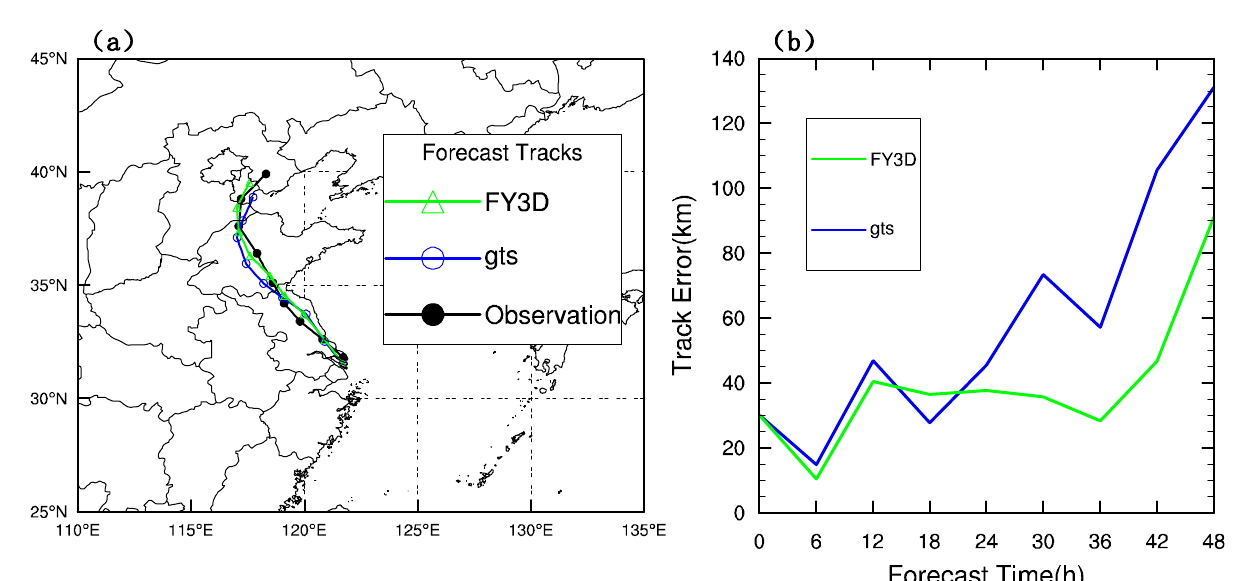
Figure 13. The deterministic forecast of ( a ) tracks and ( b ) track errors (unit: km).